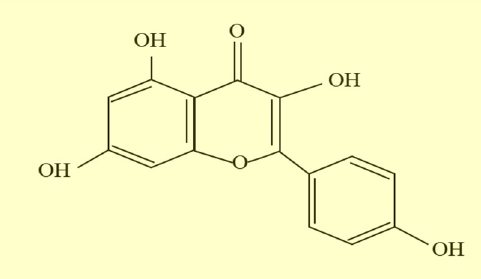
Figure 1. Chemical structure of Kaempferol [26].